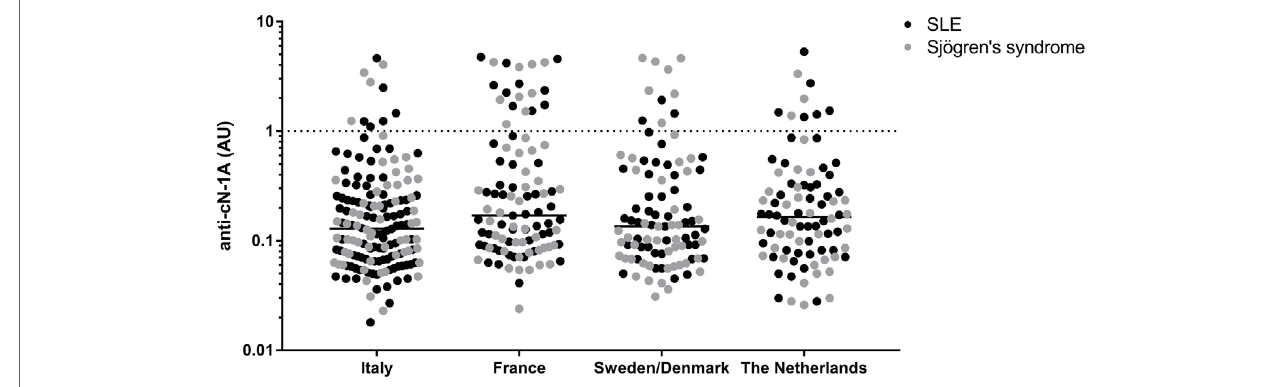
FigUre 1 | Distribution of anti-cN-1A reactivity in primary Sjögren’s syndrome and systemic lupus erythematosus (SLE) patients from different countries. Dotted line = cutoff of anti-cN-1A reactivity (1.0